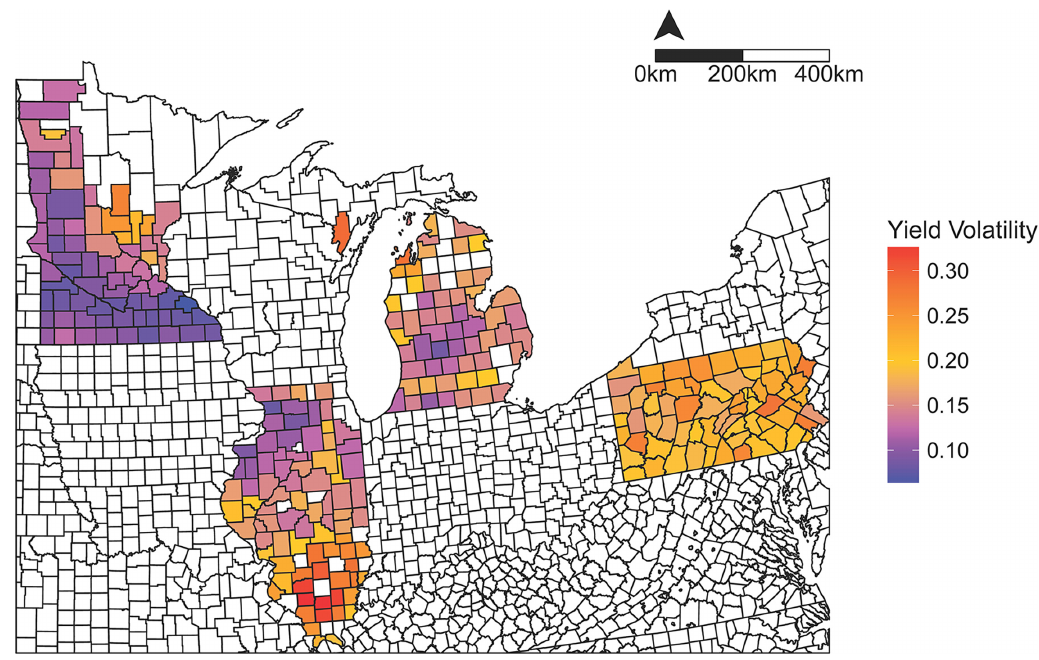
Fig 2. County-level maize yield volatility (coefficient of variation) in each state over 2000 – 2014. Minnesota (top left state) had the least yield volatility and Pennsylvania (far right) the most. Illinois (second from left) had the greatest variation in yield